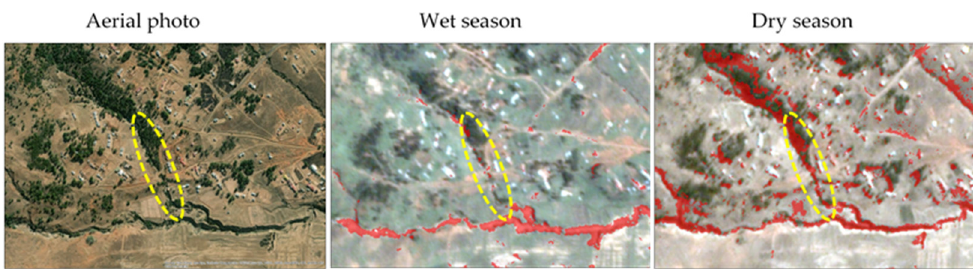
Figure 8. An example of a vegetated gully (dashed yellow ellipse) in the dry and wet seasons.